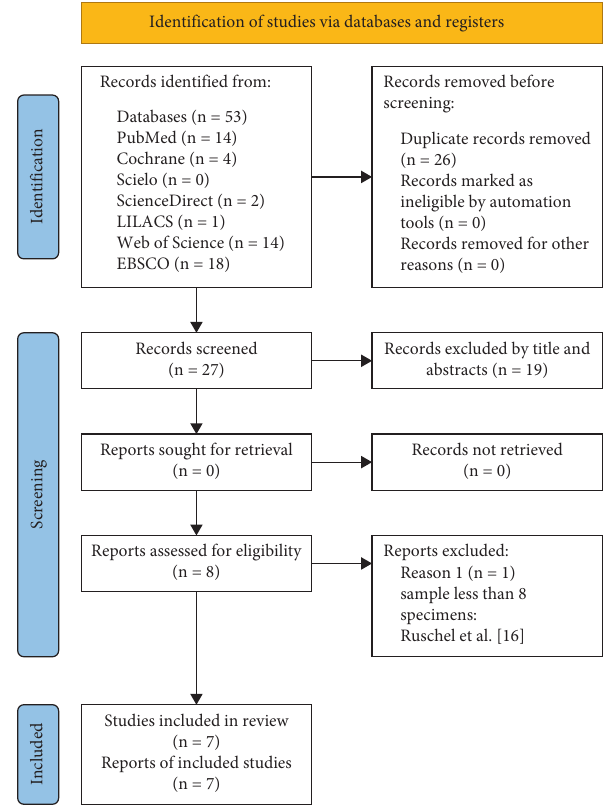
Figure 1: PRISMA flow chart that relates the search information according to the eligibility criteria.